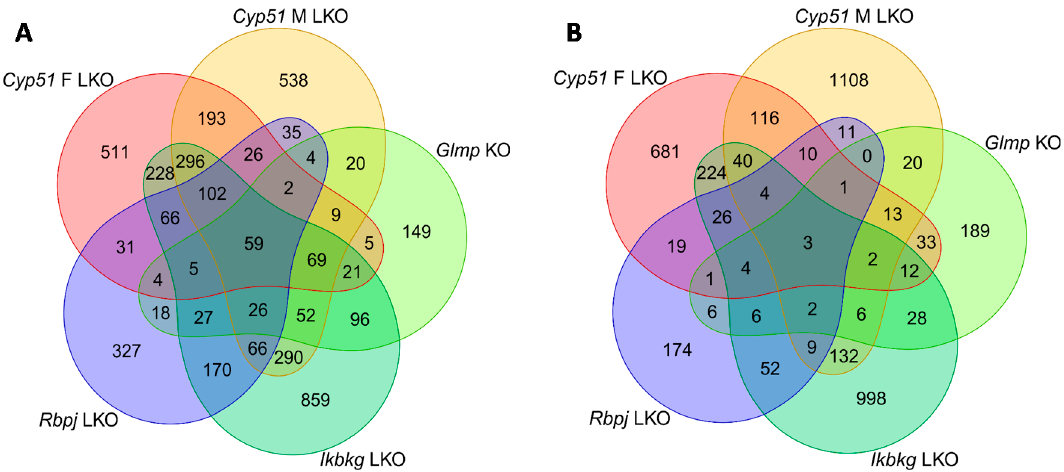
Figure 1. Venn diagrams of differentially expressed genes (DEGs) in mouse genetic models of liver fibrosis. ( A ) Upregulated DEGs. ( B ) Downregulated DEGs.